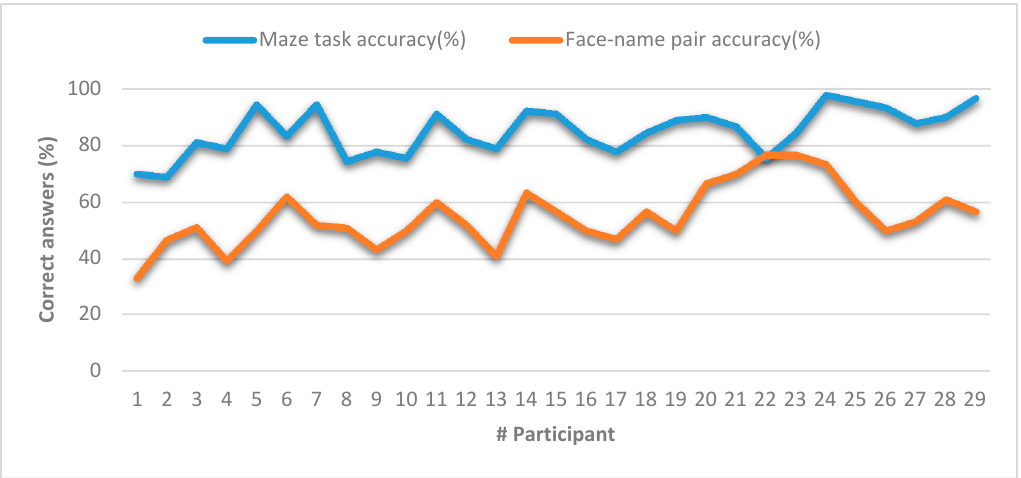
Table 3. Correlation between the response accuracy of both the maze task and the face–name pair test (autonomous mode).